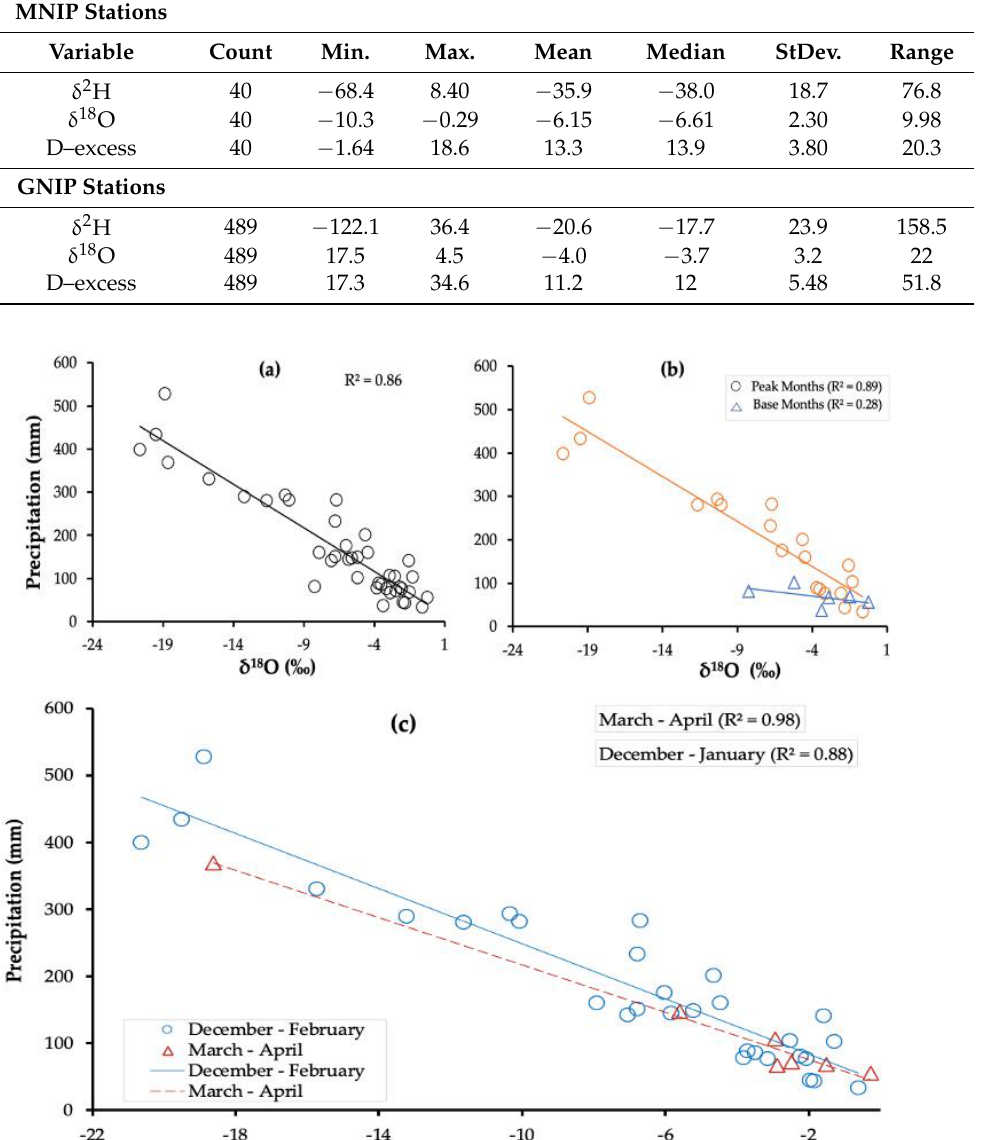
Table 3. Summary of stable isotopic signatures of precipitation from (a) MNIP stations and surround- ing GNIP stations.